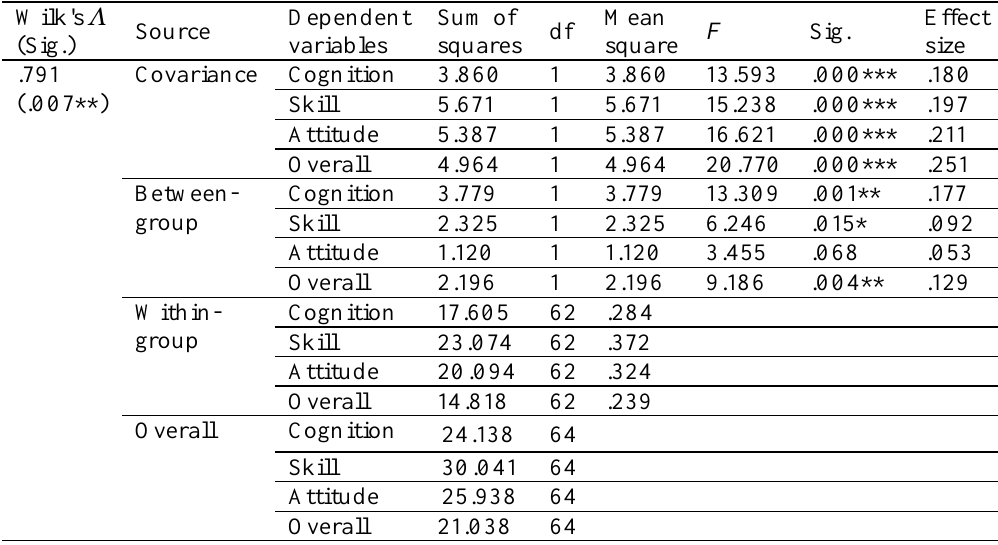
MANCOVA Summary on Self-Assessment Scores of Both Groups Wilk's Λ